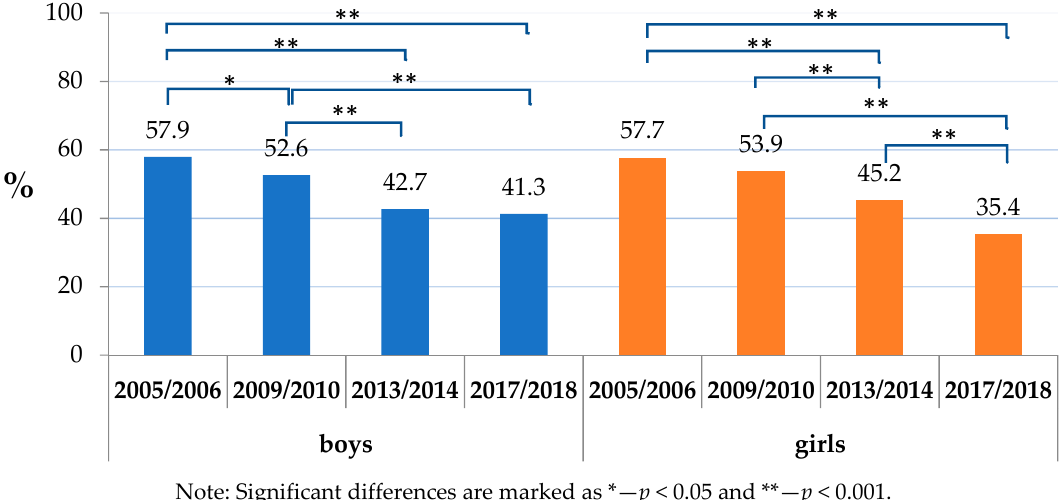
Figure 2. Consumption of sweets or sweetened soft drinks by sex.